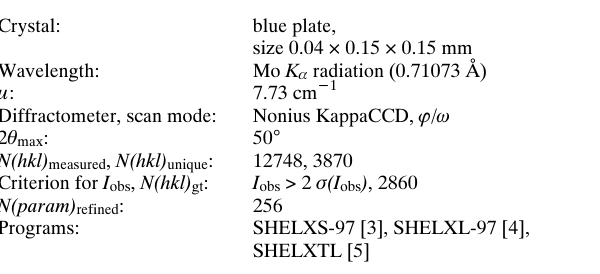
Table 1. Data collection and handling.